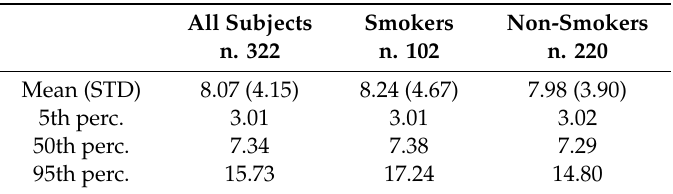
Table 3. Urinary concentrations of 3-NO 2 Tyr in the subgroup of 322 subjects, in smokers and non-smokers expressed in µ g / g